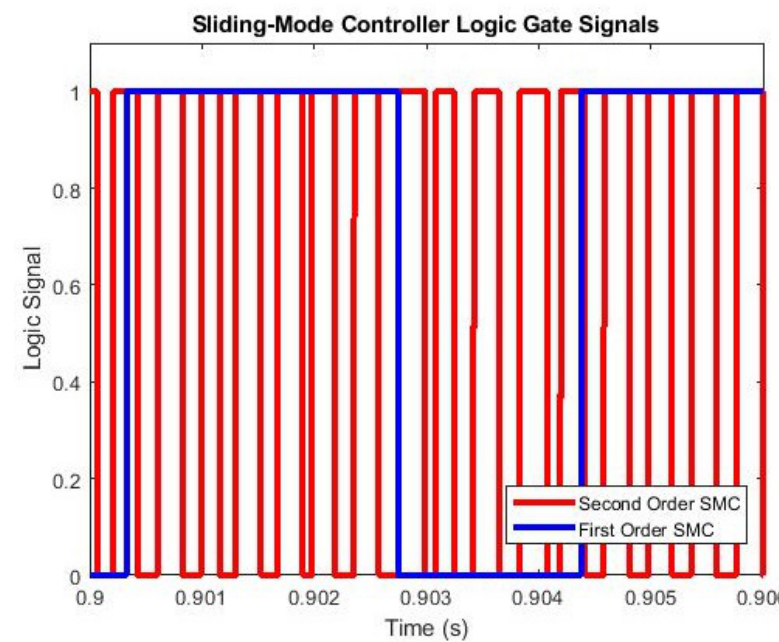
Figure 24. SMC buck-boost converter gate control signal. Figures 25 and 26 show the line-to-line and line-to-neutral output voltage profile of voltage-oriented control (VOC) based space-vector pulse-width-modulated inverter, feeding three-phase power to the micro-grid or industrial AC loads.